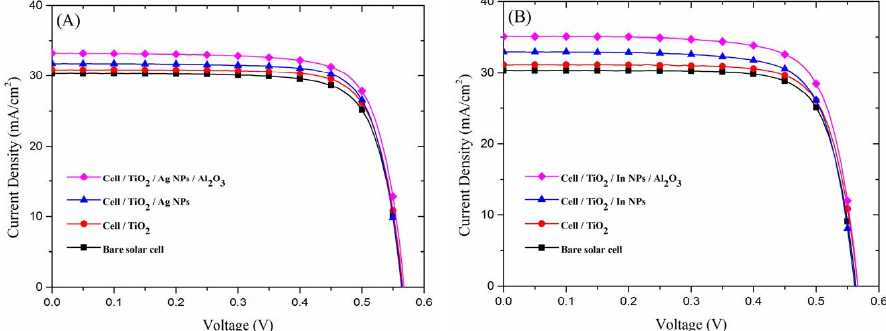
Figure 9. Photovoltaic current density-voltage (J-V) curves: ( A ) Bare cell, cell with TiO 2 spacer layer, cell with Ag-NPs on TiO 2 spacer layer, and cell with Ag-NPs embedded in Al 2 O 3 ; ( B ) Bare cell, cell with TiO 2 spacer layer, cell with In-NPs on TiO 2 spacer layer, and cell with In-NPs embedded in Al 2 O 3 .